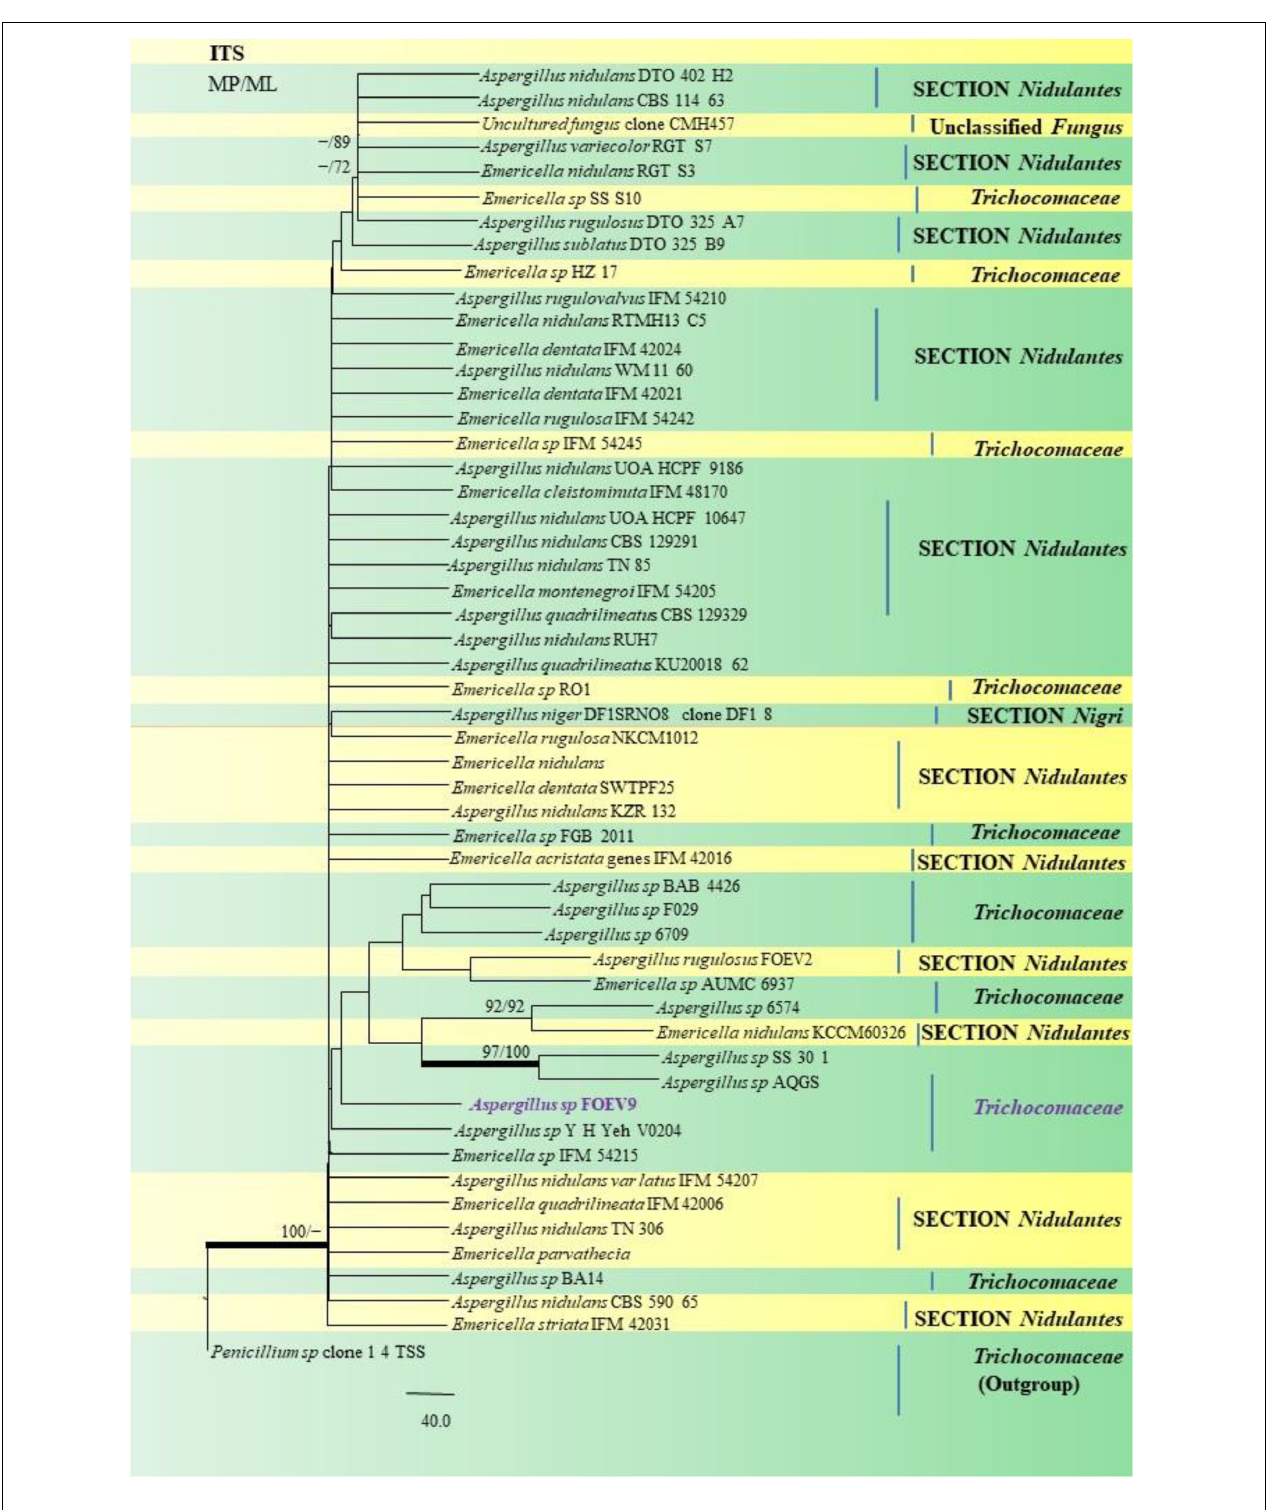
FIGURE 12 | A phylogenetic tree (taxon branching diagram) which presents the genetic analysis of the Aspergillus sp. FOEV9 clade belonging to the family Trichocomaceae , exhibiting a maximum parsimony analysis of partial ITS 1 and ITS 4 concatenated sequences, acquired. Bootstrap (bs) values ≥ 70% are designated at the nodes for maximum parsimony (MP) and maximum likelihood (ML) methods; branches with values ≥ 95% bs are bold black. A specific isolate code was mentioned as a suffix to the species name. Hyphen (-) represents the range of support values for parsimony and RAxML analyses of below 70%. Our isolate, which is marked in purple, was rooted using Penicillium species clone 1 4